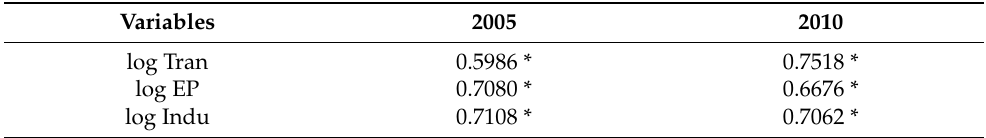
Table 4. Results of the correlation analysis between urban expansion and pollutant emissions based on the geographic weighted regression (GWR) model (N = 204).